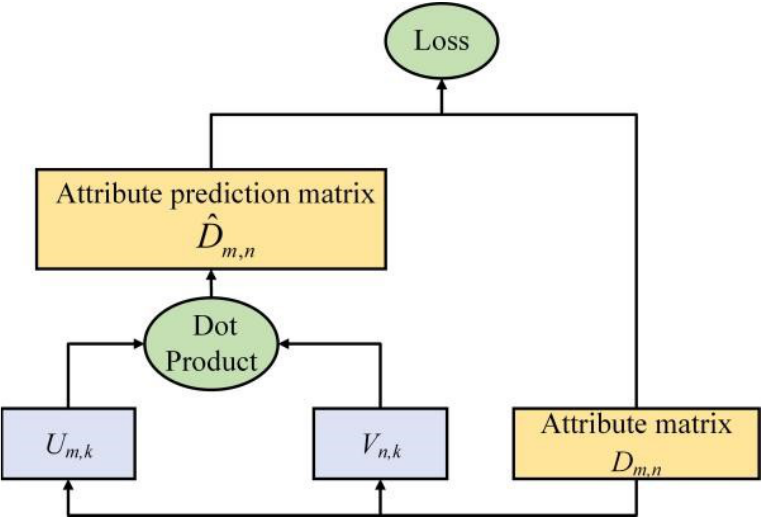
Figure 4. Architecture diagram of the matrix decomposition of attributes.